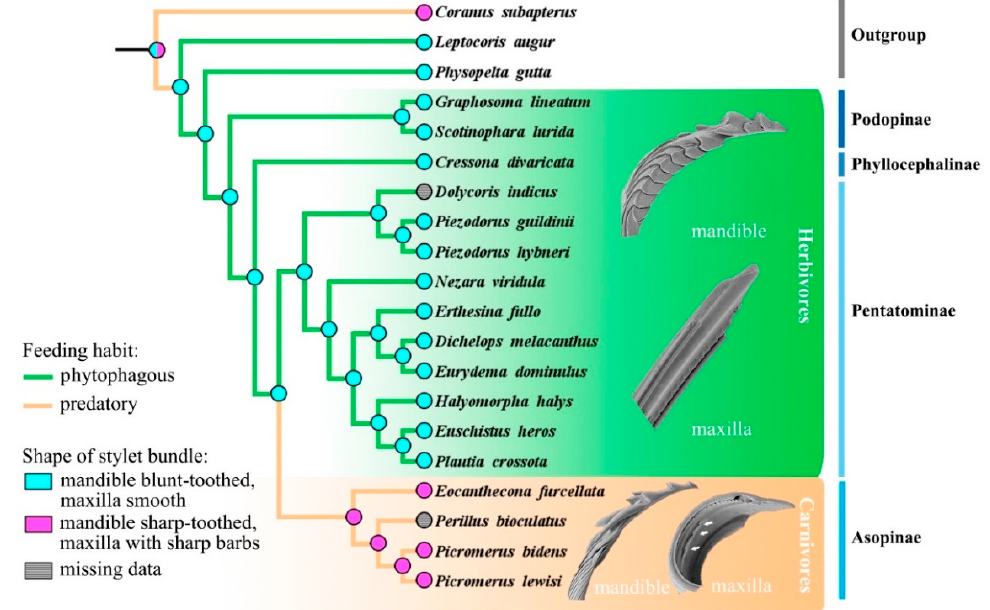
Figure 9. Ancestral state reconstruction of the shapes of mandibles and maxillae in Pentatomidae based on parsimony. The cladogram used for reconstruction was the single tree obtained based on the cox1 and rrnL genes analyzed using the maximum likelihood method.